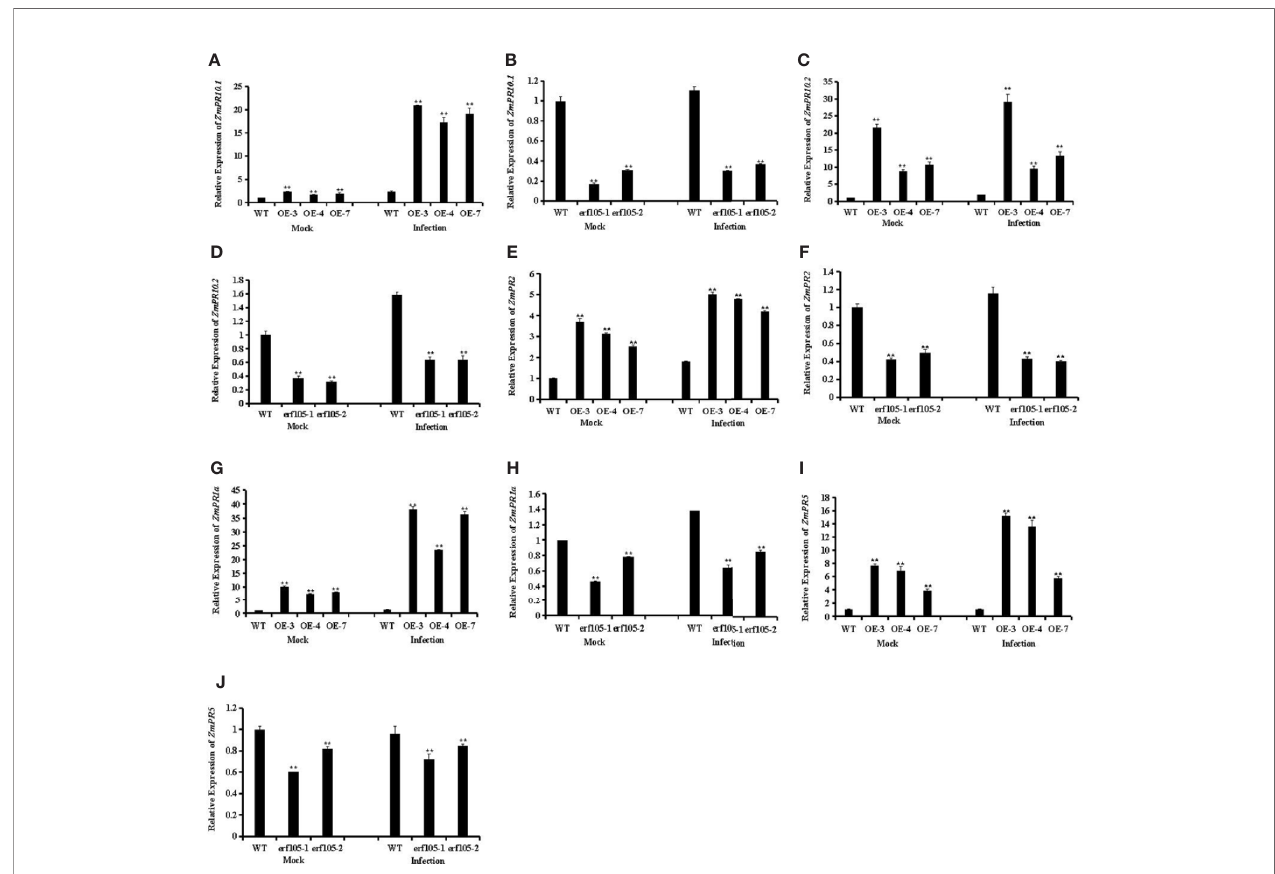
FIGURE 8 | Relative expression levels of defense-related genes under mock treatment and infected by E. turcicum at 24 hpi in ZmERF105 over-expression and erf105 mutant lines, respectively. (A, B) The expression of the ZmPR10.1. (C, D) The expression of the ZmPR10.2 . (E, F) The expression of the ZmPR2. (G, F) The expression of the ZmPR1a. (H, I) The expression of the ZmPR5. The relative expression levels were calculated by the 2 − DD Ct method with the maize housekeeping gene ZmTub (GRMZM2G066191) as an internal control. The expression of the WT sample [mock-treated wild-type (WT) plants] was set to unity. The experiment was performed using three biological and technical replicates each and analyzed using Student ’ s t -tests (**P < 0.01). Bars indicate standard error of the mean